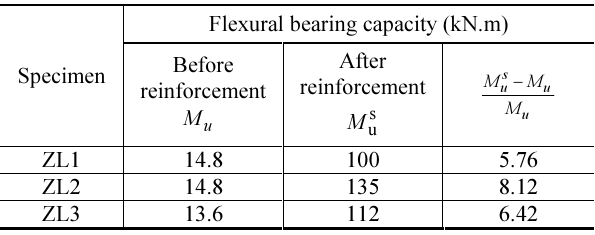
Table 7. Comparison of flexural bearing capacity of specimen before and after strengthening contrast Flexural bearing capacity Specimen